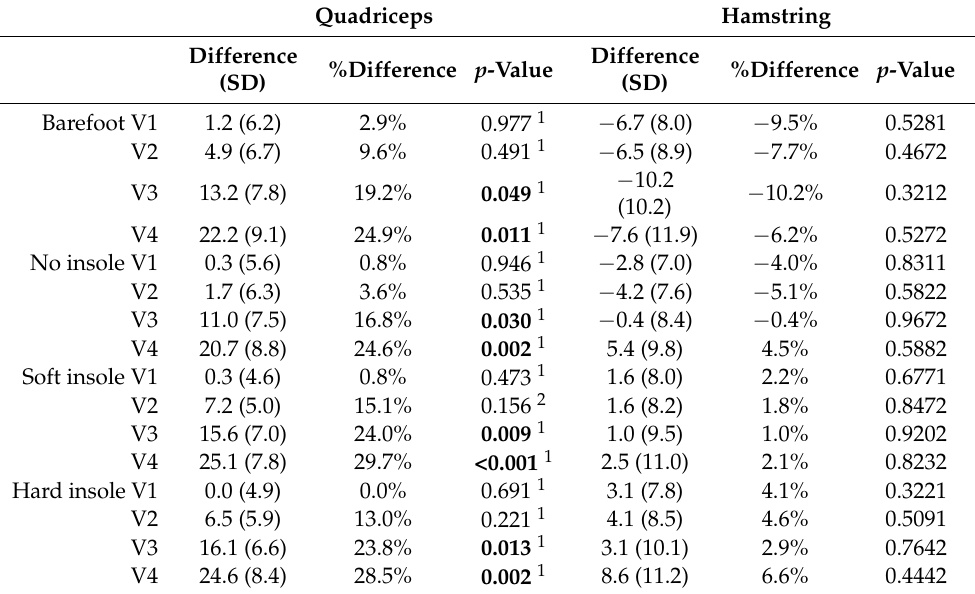
Difference %Difference p (SD)